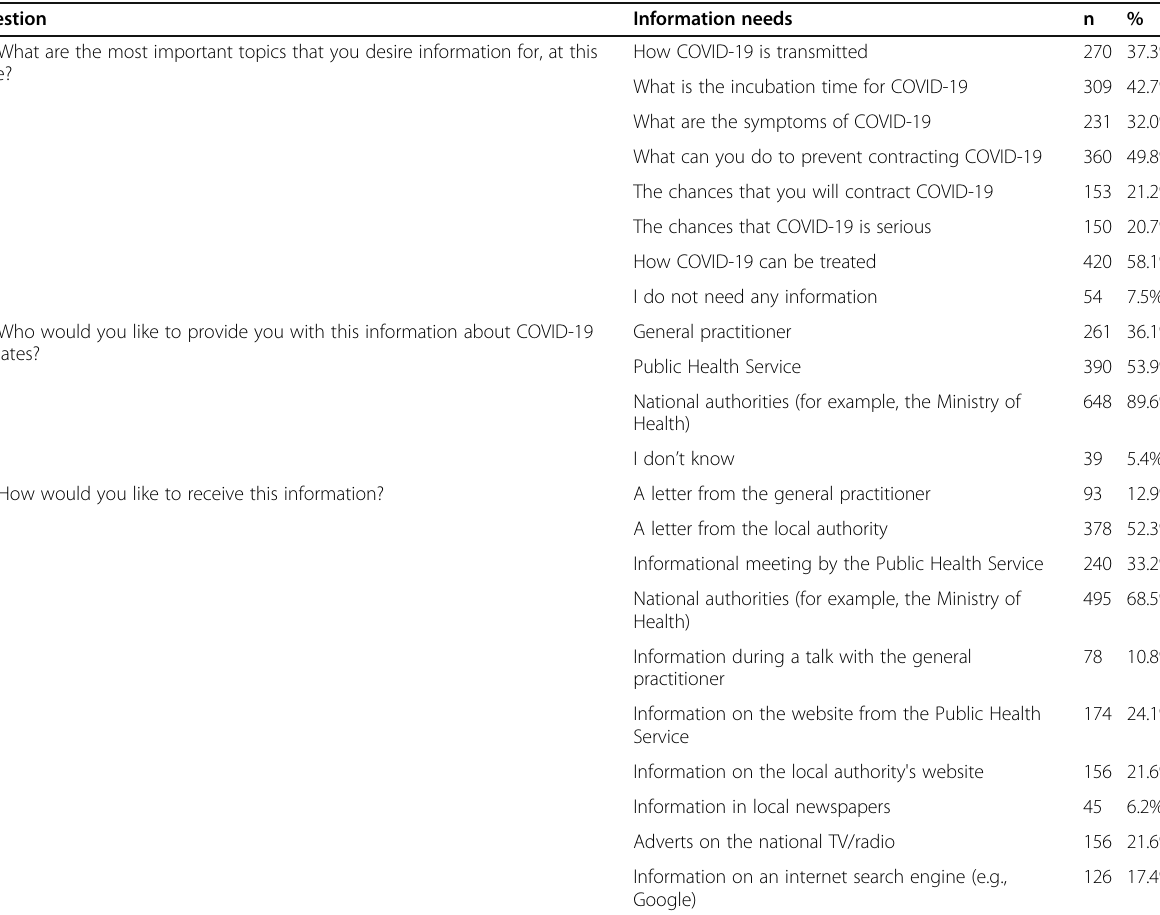
Table 14 Information needs regarding COVID-19, according to participants ( N = 723) Question Information